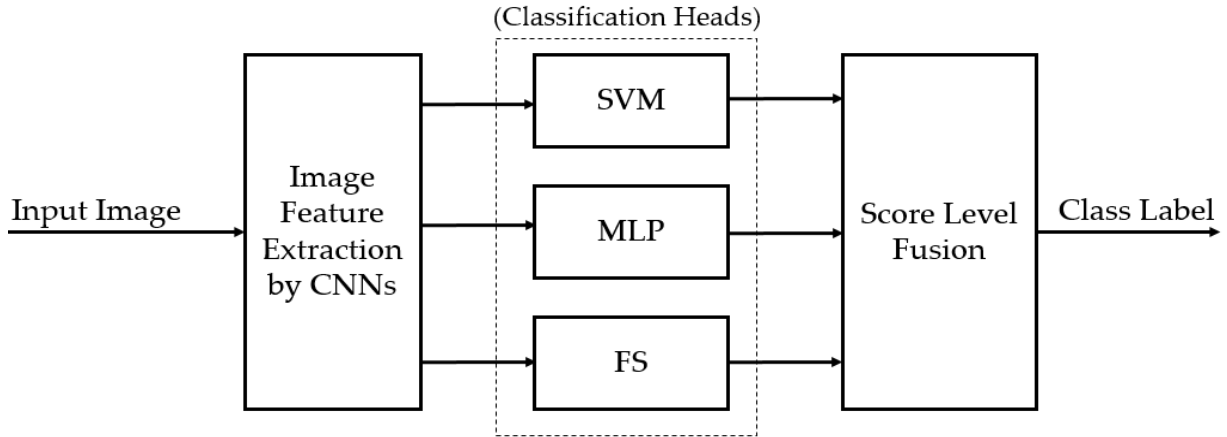
Figure 1. Overview of our proposed Figure 1 . Overview of our proposed method .